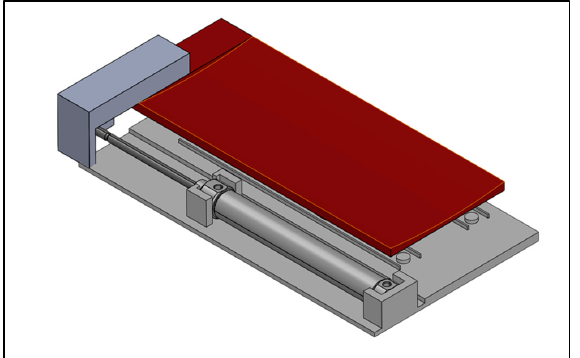
Figure 2. Spinetrack device.